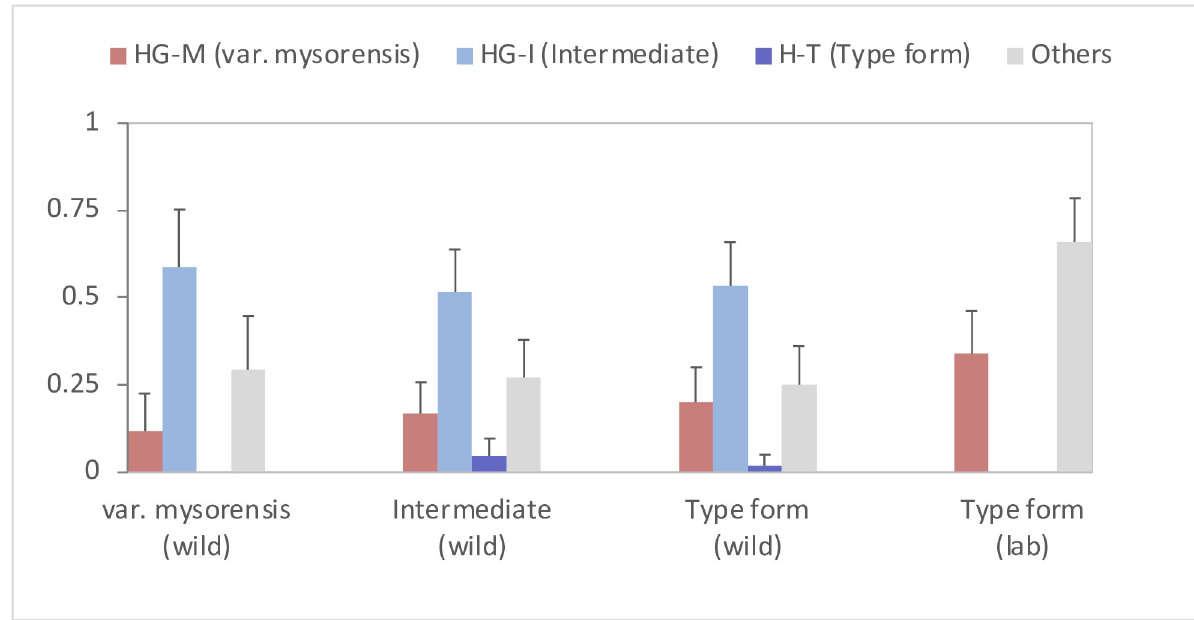
Fig 3. Distribution of haplotype groups in morphologically identified biological forms in field populations and a laboratory strain. Error bars represent 95% confidential interval (CI).